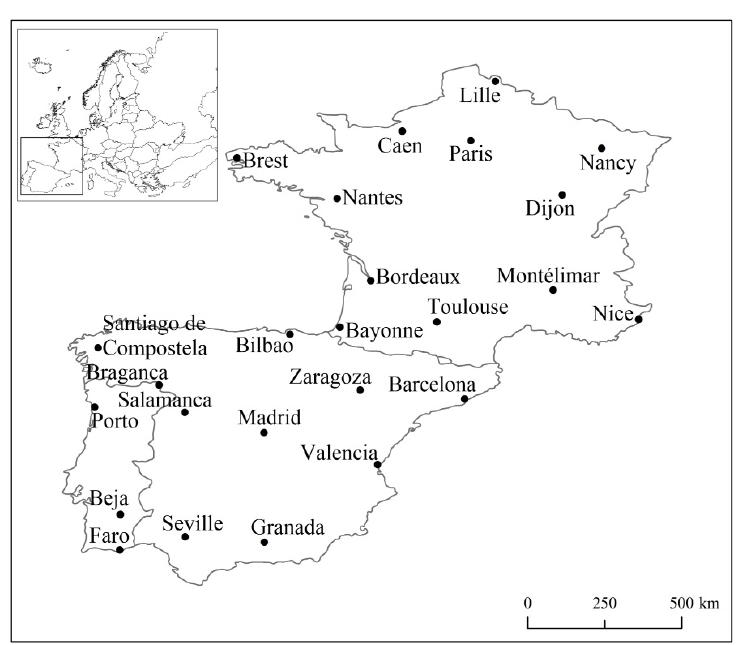
Figure 1. Locations of the meteorological stations.